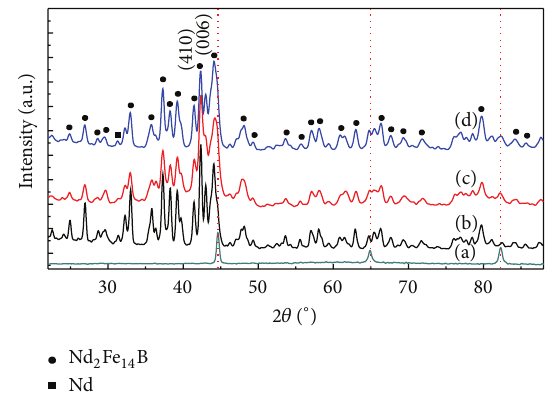
Figure 1: XDR diagrams of (a) Fe 65 Co 35 alloy, (b) Nd 16 Fe 76 B 8 alloy, (c) melt-spun Nd 16 Fe 76 B 8 /40%wt. Fe 65 Co 35 ribbon without assisted magnetic field, and (d) melt-spun Nd 16 Fe 76 B 8 /40% wt. Fe 65 Co 35 ribbon with assisted magnetic field. The dashed curves indicate the phase of Fe 65 Co 35